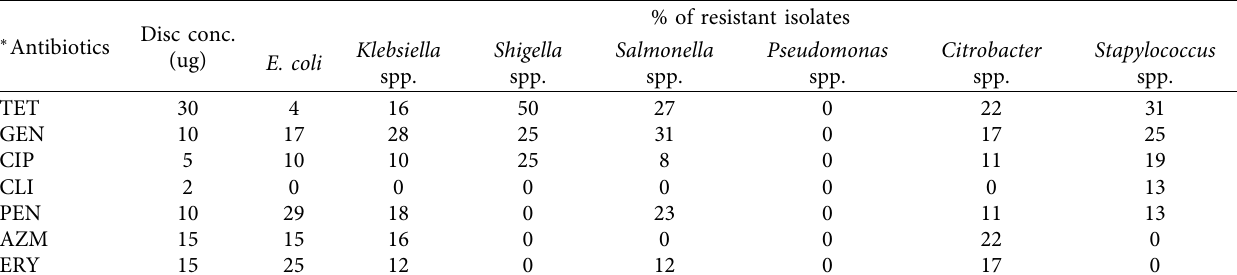
Table 3: Resistance profiles of bacterial spp. isolated from open-air markets and supermarkets. ∗ Antibiotics Disc